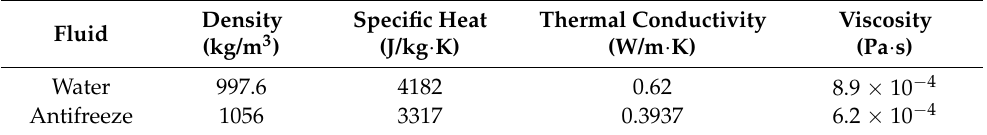
Table 5. Physical parameters of antifreeze and